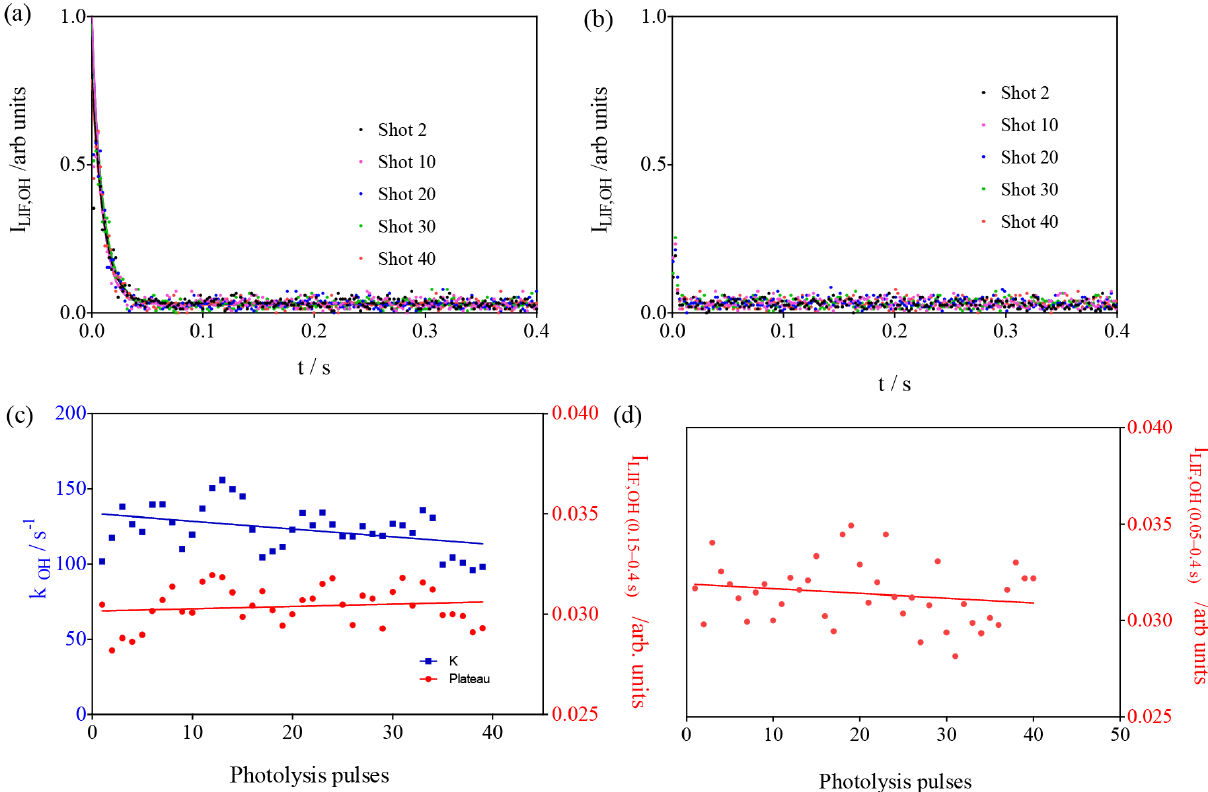
Figure 6. Experiments with high isoprene concentrations: [ C 5 H 8 ]= 1.23 × 10 12 and 1.23 × 10 13 moleculecm − 3 for left and right graph, respectively. (a, b) LIF signals as a function of the number of photolysis pulses (for clarity, only every 10th pulse is shown); (c, d) show the rate constant in blue (decay was too fast to be measurable under the conditions of b ) and the LIF intensity at long times in red (plateau from fitting for c ; average of all data points between 0.01 and 0.4s for d